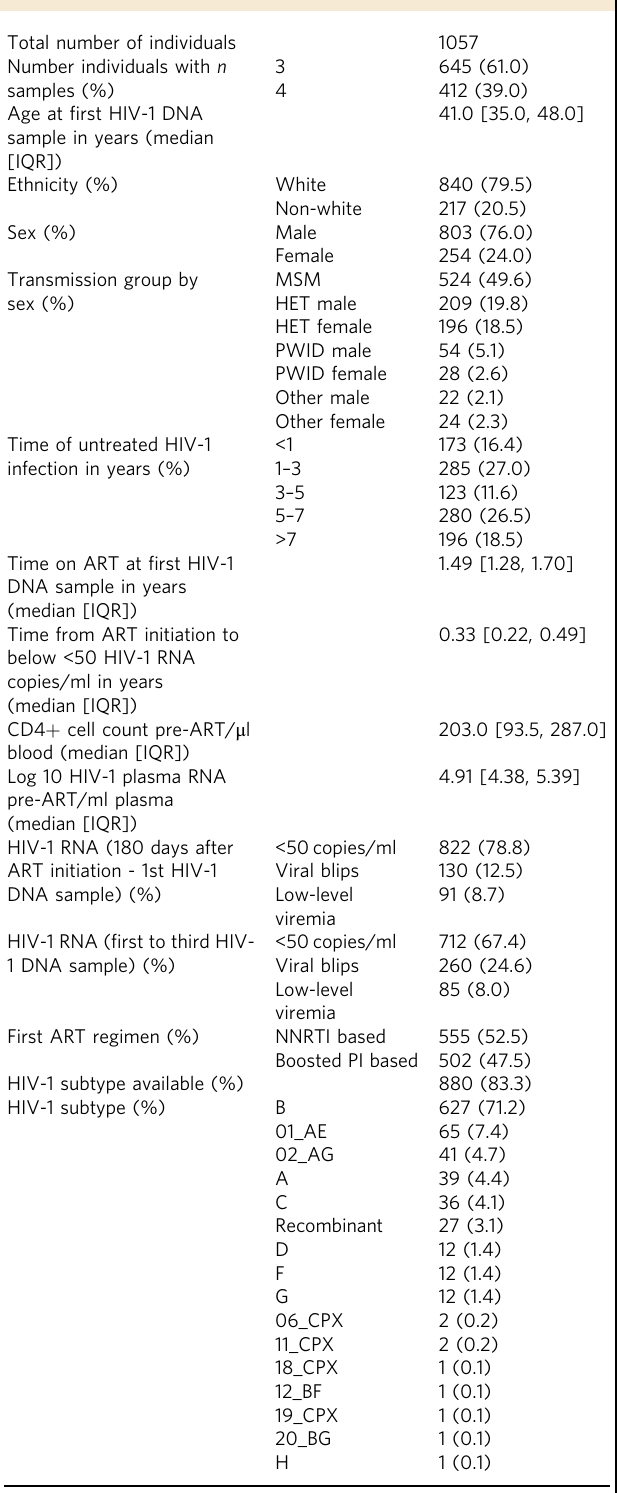
Table 1 Individuals ’